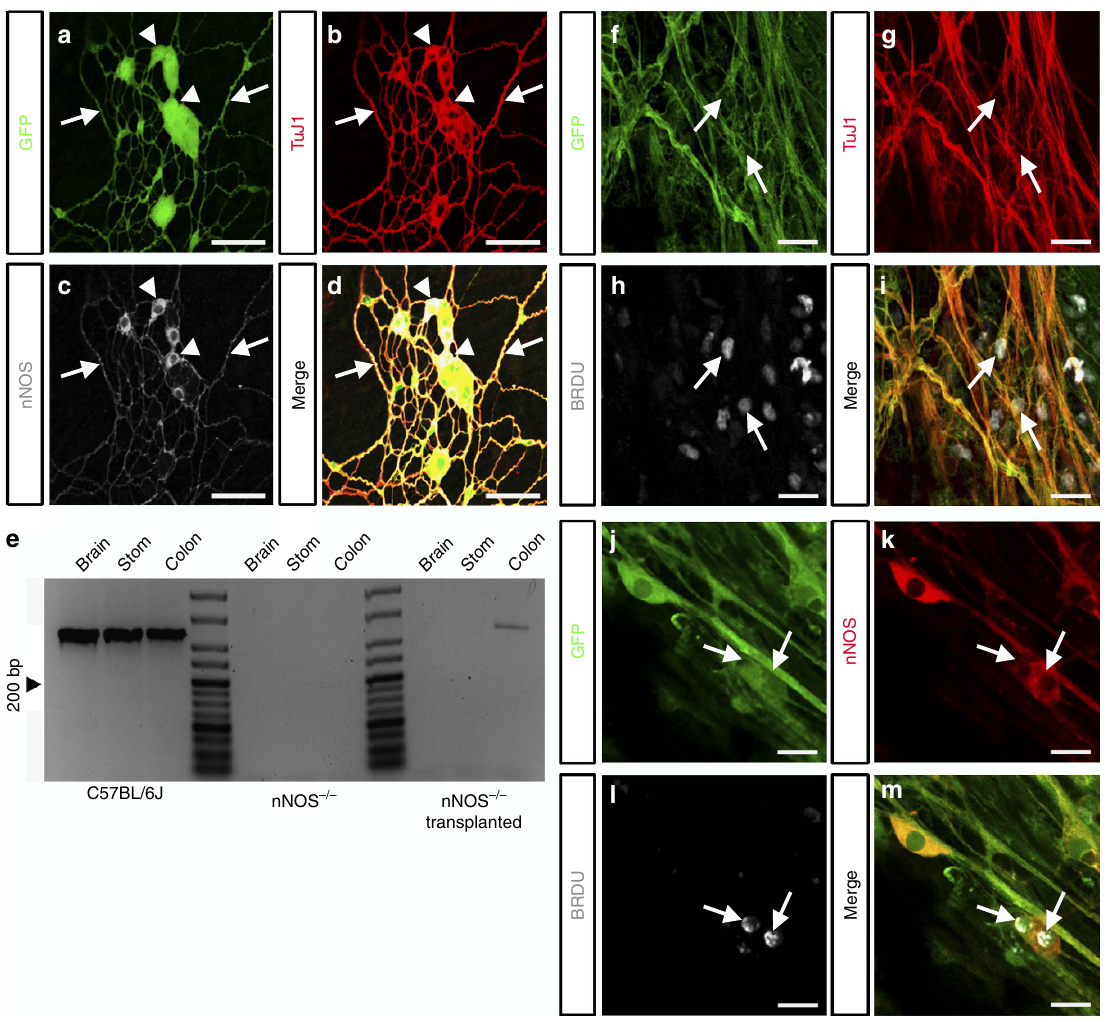
Figure 2 | Transplanted ENSC form nNOS þ neurons within the nNOS (cid:2) / (cid:2) distal colon. ( a – c ) Representative confocal z-stack images demonstrating individual channels for GFP ( a ), TuJ1 ( b ) and nNOS ( c ) within a transplanted cell network present in the nNOS (cid:2) / (cid:2) distal colon. ( d ) Merged image of individual channels shown in ( a – c ) demonstrating triple labelling of transplanted YFP þ cells (green) co-expressing the neuronal marker TuJ1 (red) and the neuronal nitric oxide synthase marker nNOS (grey). Individual transplanted nNOS þ neuronal cell bodies (arrowheads) extend multiple nNOS þ projections (arrows) to form an anastomosing network of transplanted cells. Scale bar, 50 m m. ( e ) Representative PCR gel demonstrating specific nNOS expression within transplanted nNOS (cid:2) / (cid:2) colon. ( f – m ) Example confocal images of BrdU incorporation within transplanted cells 4 weeks after application. Triple labelled transplanted cells (green, f , j ) co-express either TuJ1 (red, g ) or nNOS (red, k ) having incorporated BrdU (grey, h , l ) after administration 24h post surgery. Scale bar, 20 m